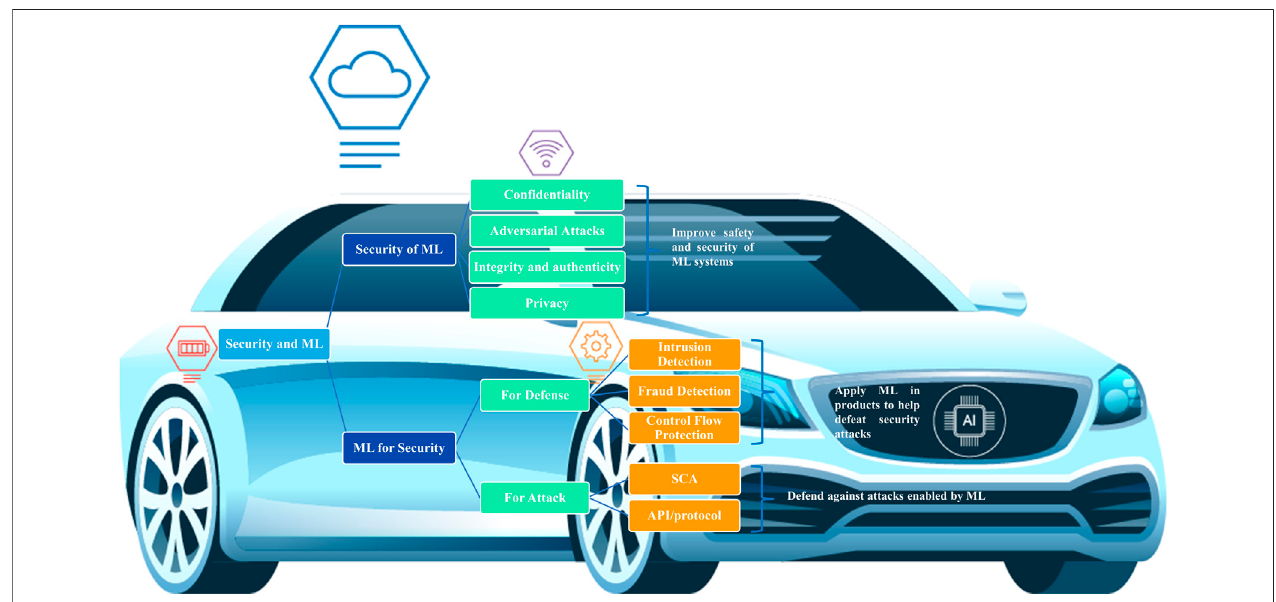
FIGURE 9 | ML, security, and privacy intersection for ECAS